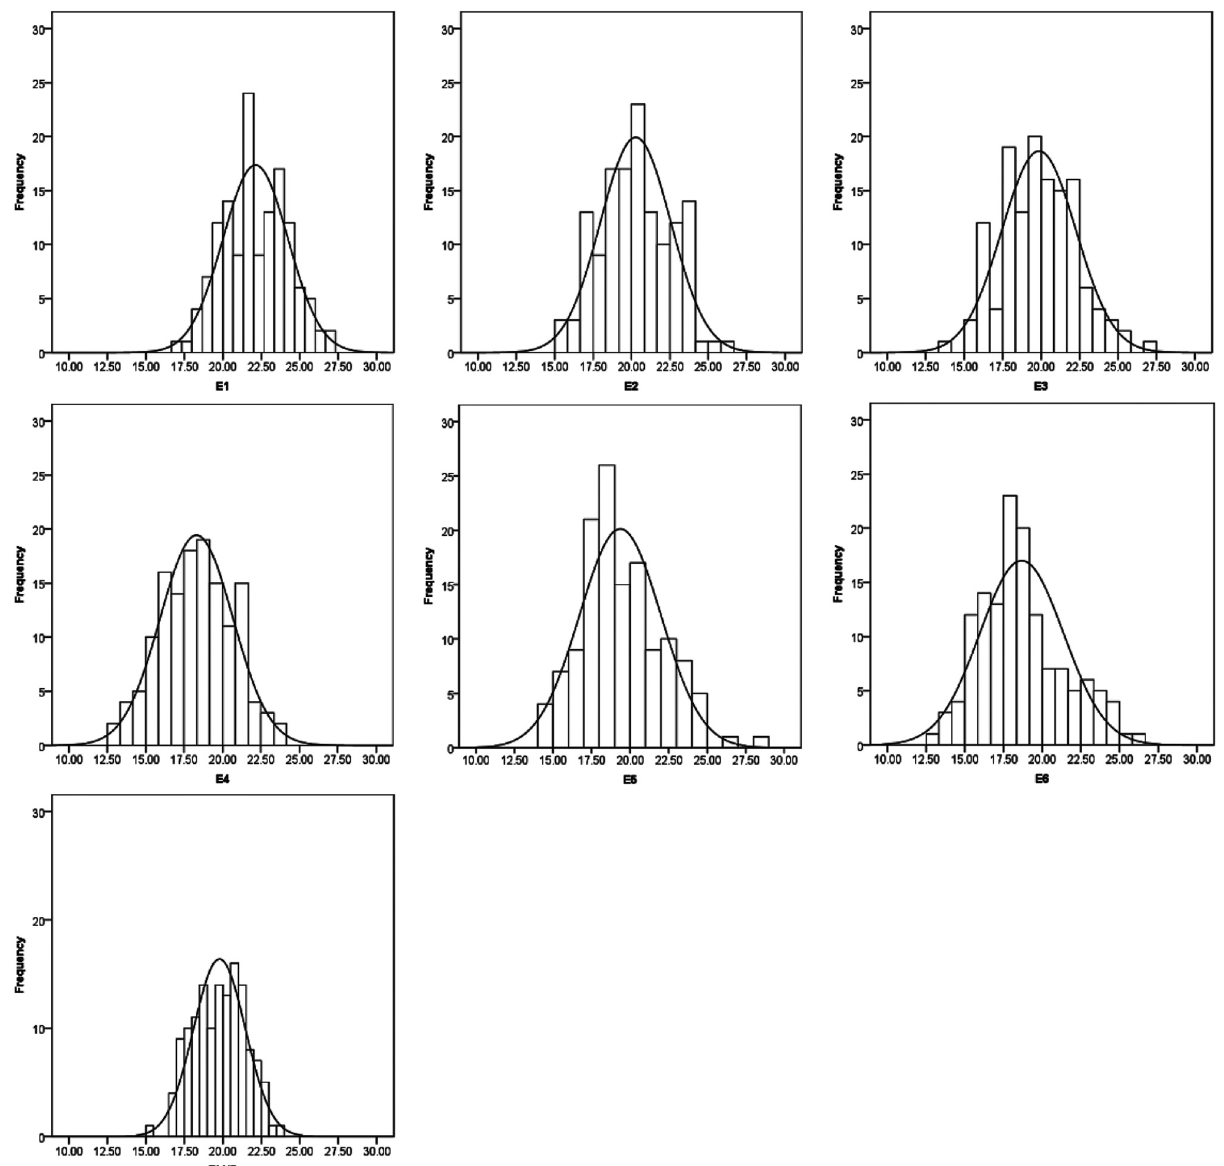
Figure 1 - Frequency distribution of TSS in the SHW-L1/Chuanmai 32 recombinant inbred line (RIL) population under 6 environments. The horizontal axis indicates TSS value, the ordinate axis indicate